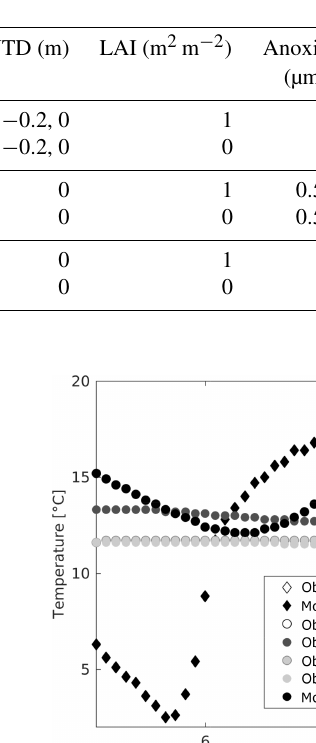
Table 3. Summary of the transition tests on model sensitivity to input data and the input combinations used in the tests.